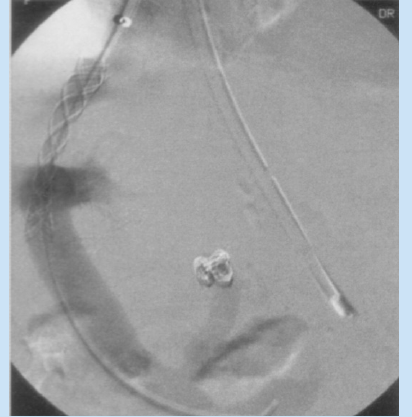
Fig. 2b. These can then be embolised before the catheters are withdrawn from the portal system.